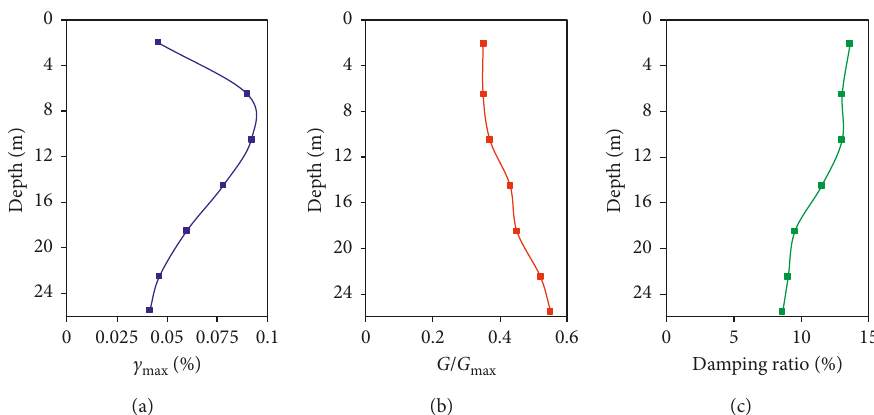
Figure 6: The results calculated from 1D nonlinear site response analysis: (a) maximum shear strain profile, (b) G / G (c) damping ratio profile.